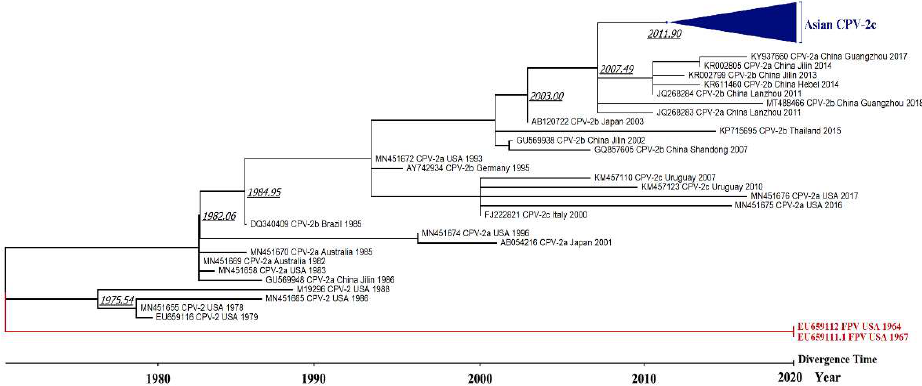
Figure 4. Time tree to infer the divergence time of CPV-2 variants. The time tree was calculated in MEGA X where divergence time was estimated using the RelTime with Dated Tips (RTDT) method [23,24]. Two FPV sequences (red color) were designated as an outgroup taxon and all sequences used the year of sampling dates as the tip dates for calibration constraints. Italicized underlined numbers at the branches indicate the divergence time estimated by the calculation. The divergence time of the Asian CPV-2c clade was estimated to be between 2011 and 2013.